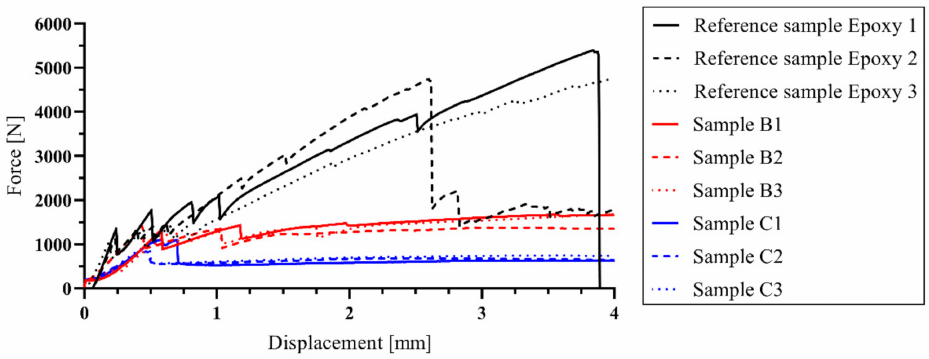
Figure 15. Evaluation of four-point bending tests of experimental samples from series A, B and